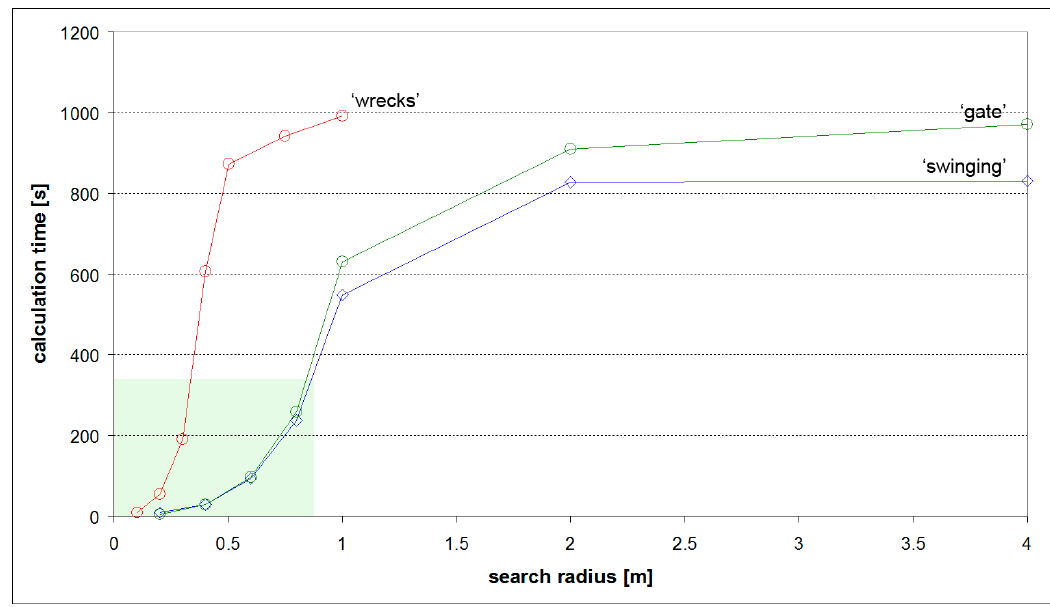
Figure 6. Calculation time for test surfaces depending on the search radius value.